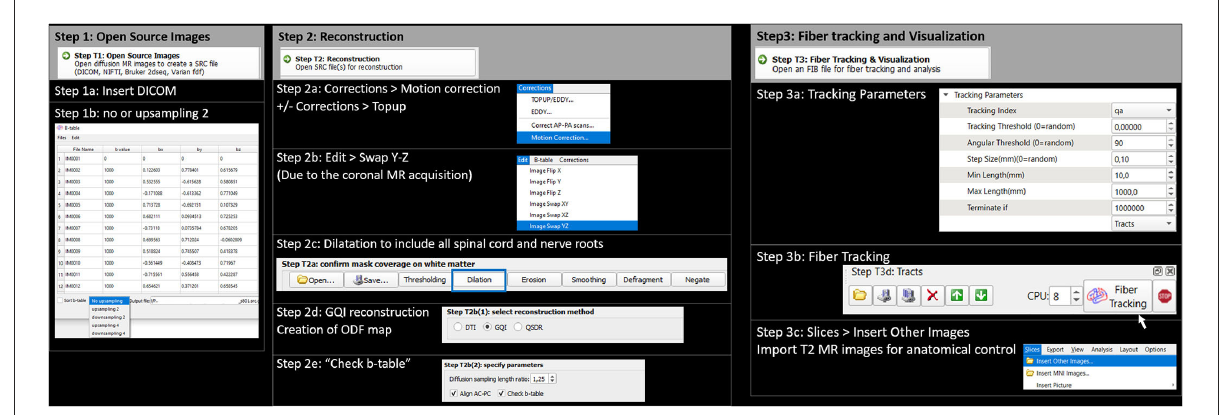
FIGURE2 Fiber tracking process using DSI Studio software package: step-by-step. Step 1: Open source images. Step 1a: Insert DICOM. Step 1b: use no upsampling (or upsampling 2). Step 2: Reconstruction. Step 2a: Artifacts correction (motion correction + /– topup). Step 2b: Swap images according to the Y – Z axis because of coronal MR acquisition. Step 2c: Dilatation of the working mask to include all the spinal cord and nerve roots. Step 2d: GQI (generalized Q-sampling imaging) reconstruction. Step 2e: check the b-table (necessary because of the image swap performed above). Step 3: Fiber tracking and visualization. Step 3a: Use tracking parameters defined in Table 1. Step 3b: Perform fiber tracking. Step 3c: Superimpose T2-weighted images.